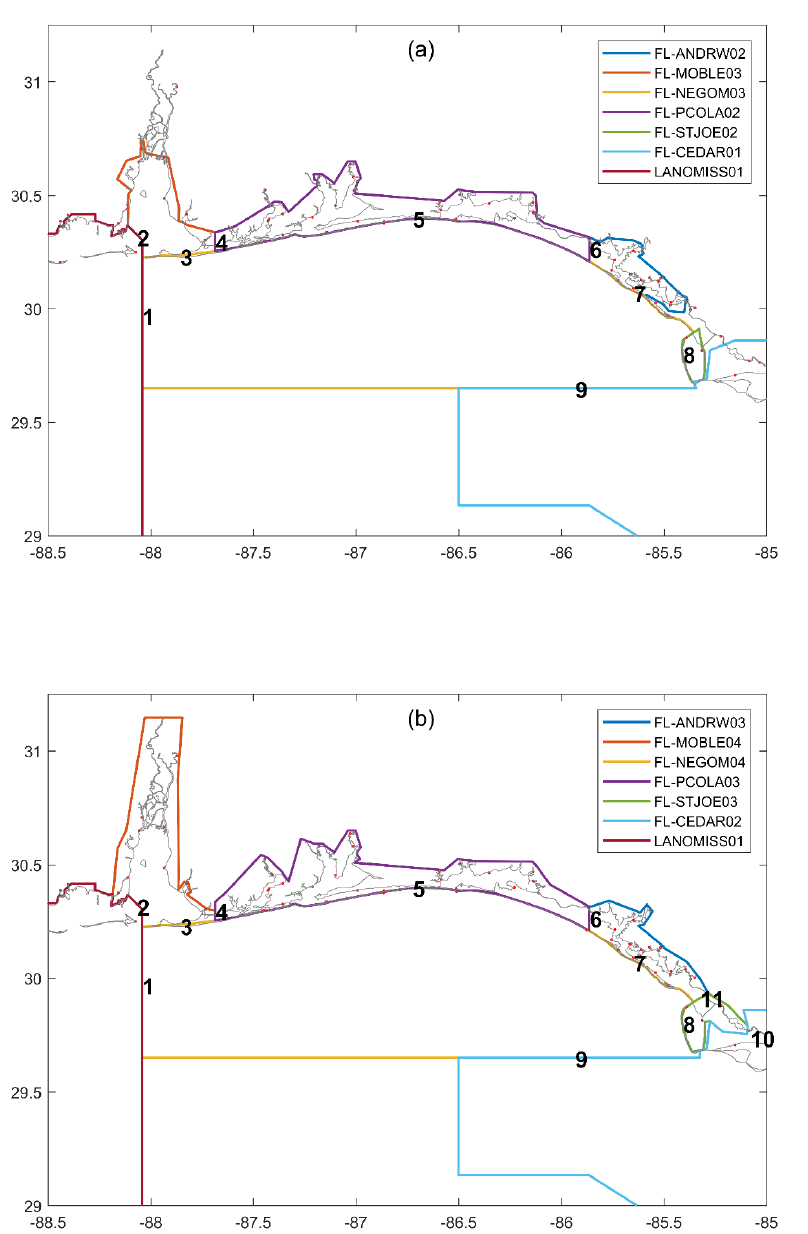
Figure 10. ( a ) 2012 and ( b ) 2018 revised bounding polygons. Dots indicate the locations of the tide